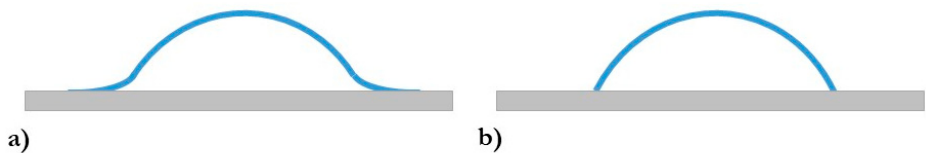
Figure 6. Sketch of the expected situation for a droplet during the spreading ( a ) and the idealized picture of such droplet considering the spherical cap approach ( b ). Notice that the definition of the true contact angle is very different in both cases.